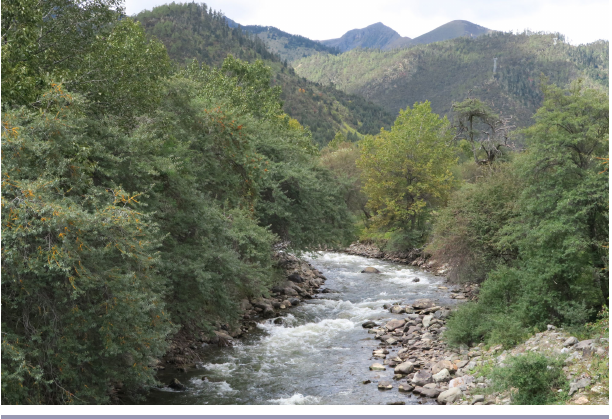
Fig. 4 . The sacred waterscape has been conserved for the burial site that is hidden behind the tree